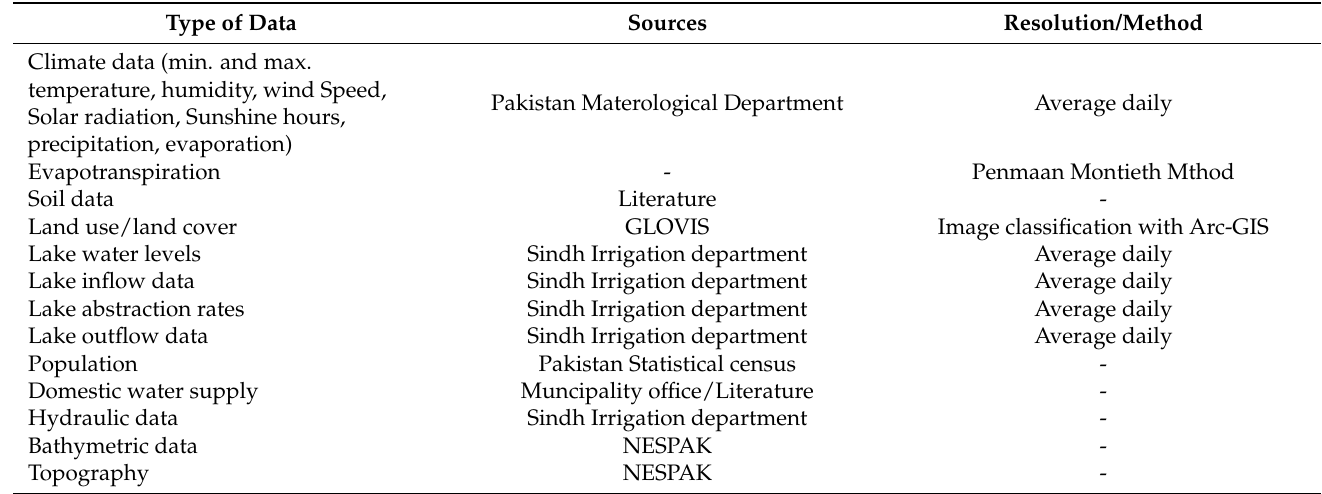
Table 2. Summary of the data used in this study and the sources from where the data is